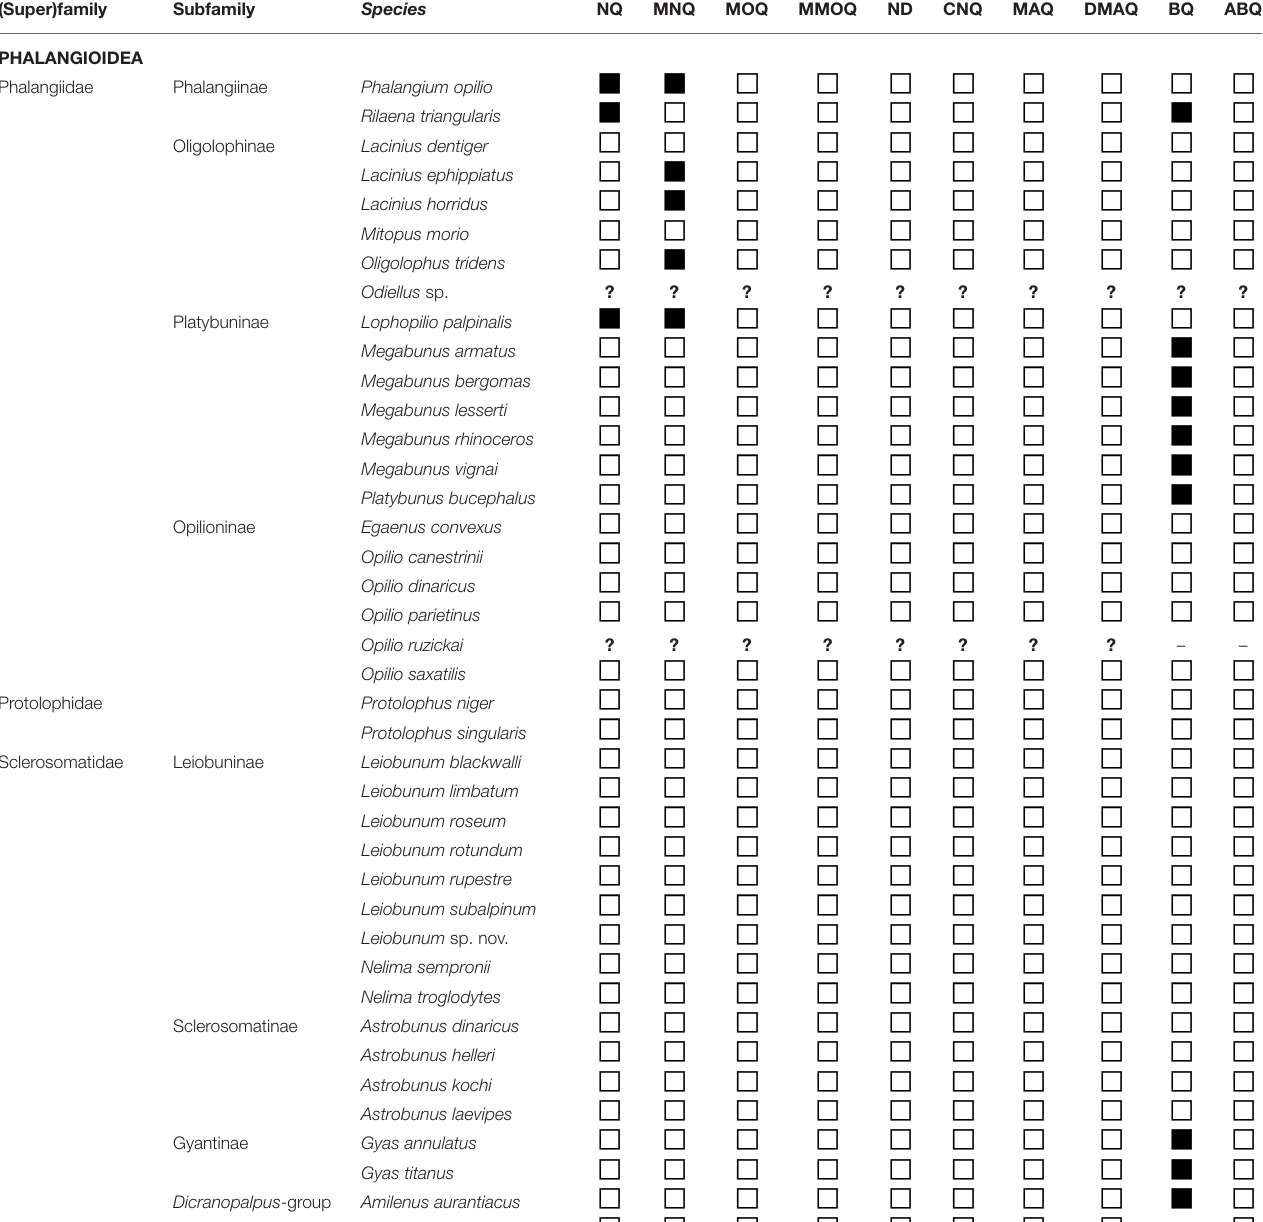
TABLE 2 | Naphtho- and benzoquinone distribution across the secretions of Eupnoi*. (Super)family